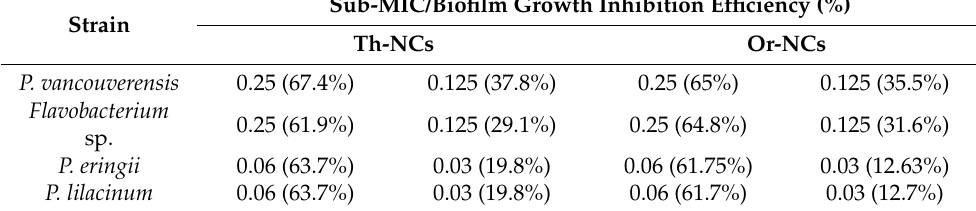
Table 2. Biofilm growth inhibition efficiency of EO-NCs against P. vancouverensis , Flavobacterium sp., P. eringii, P. lilacinum